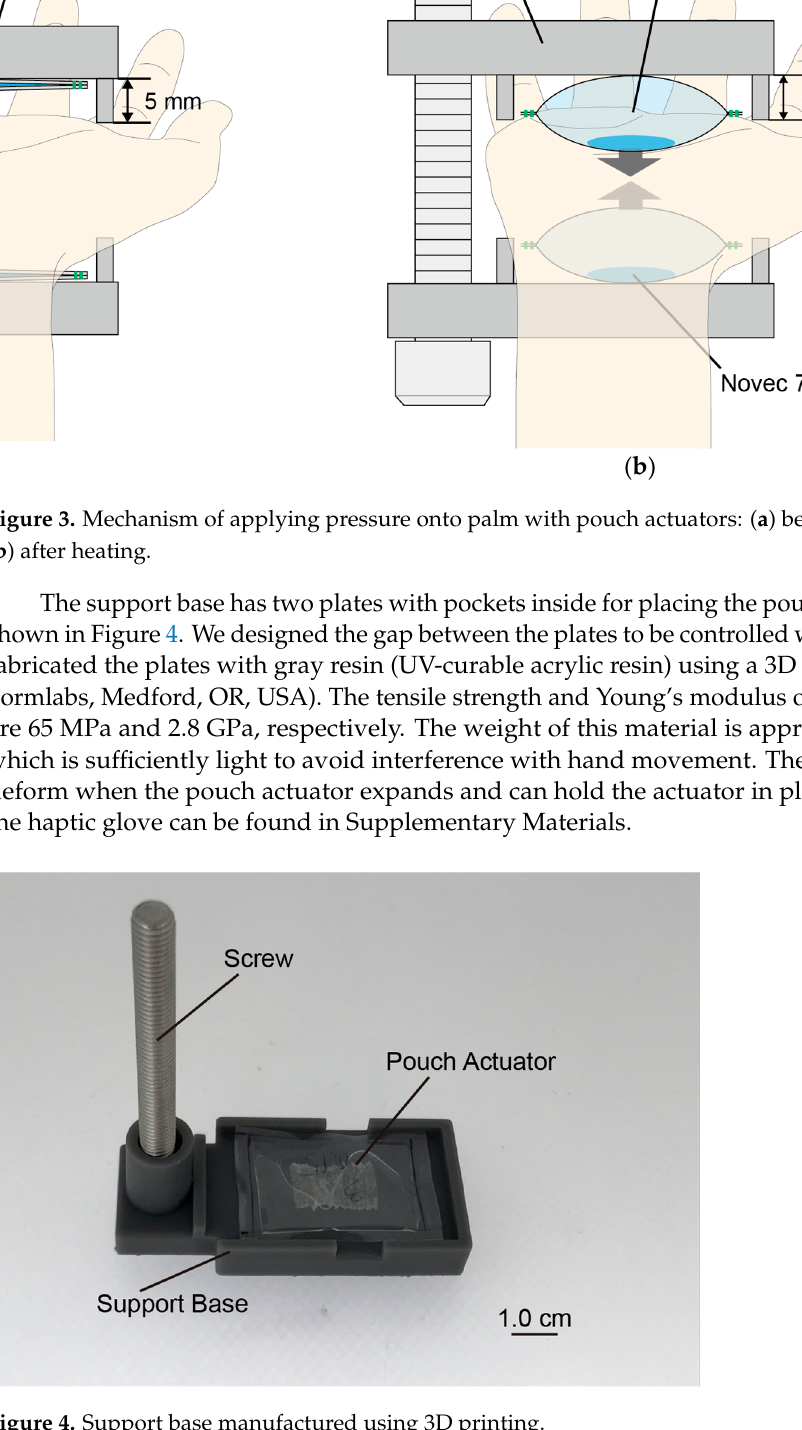
Figure 4. Support base manufactured using 3D